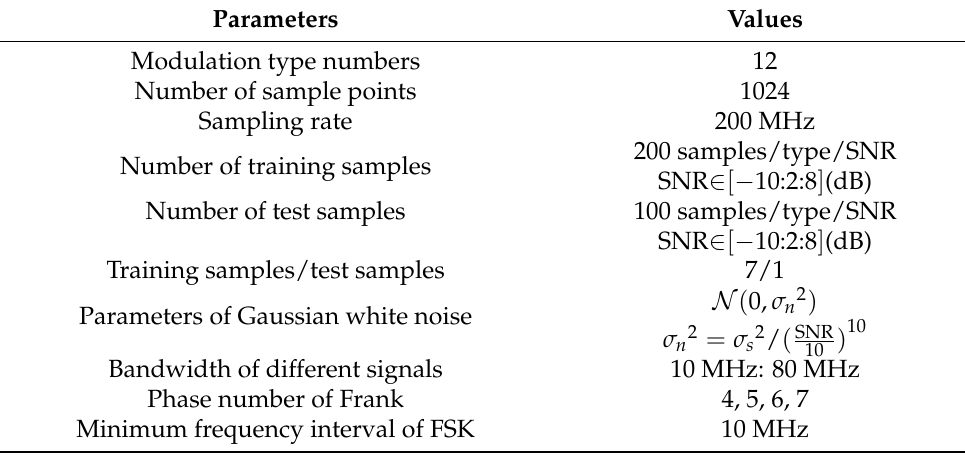
Table 1. Simulation signal parameters